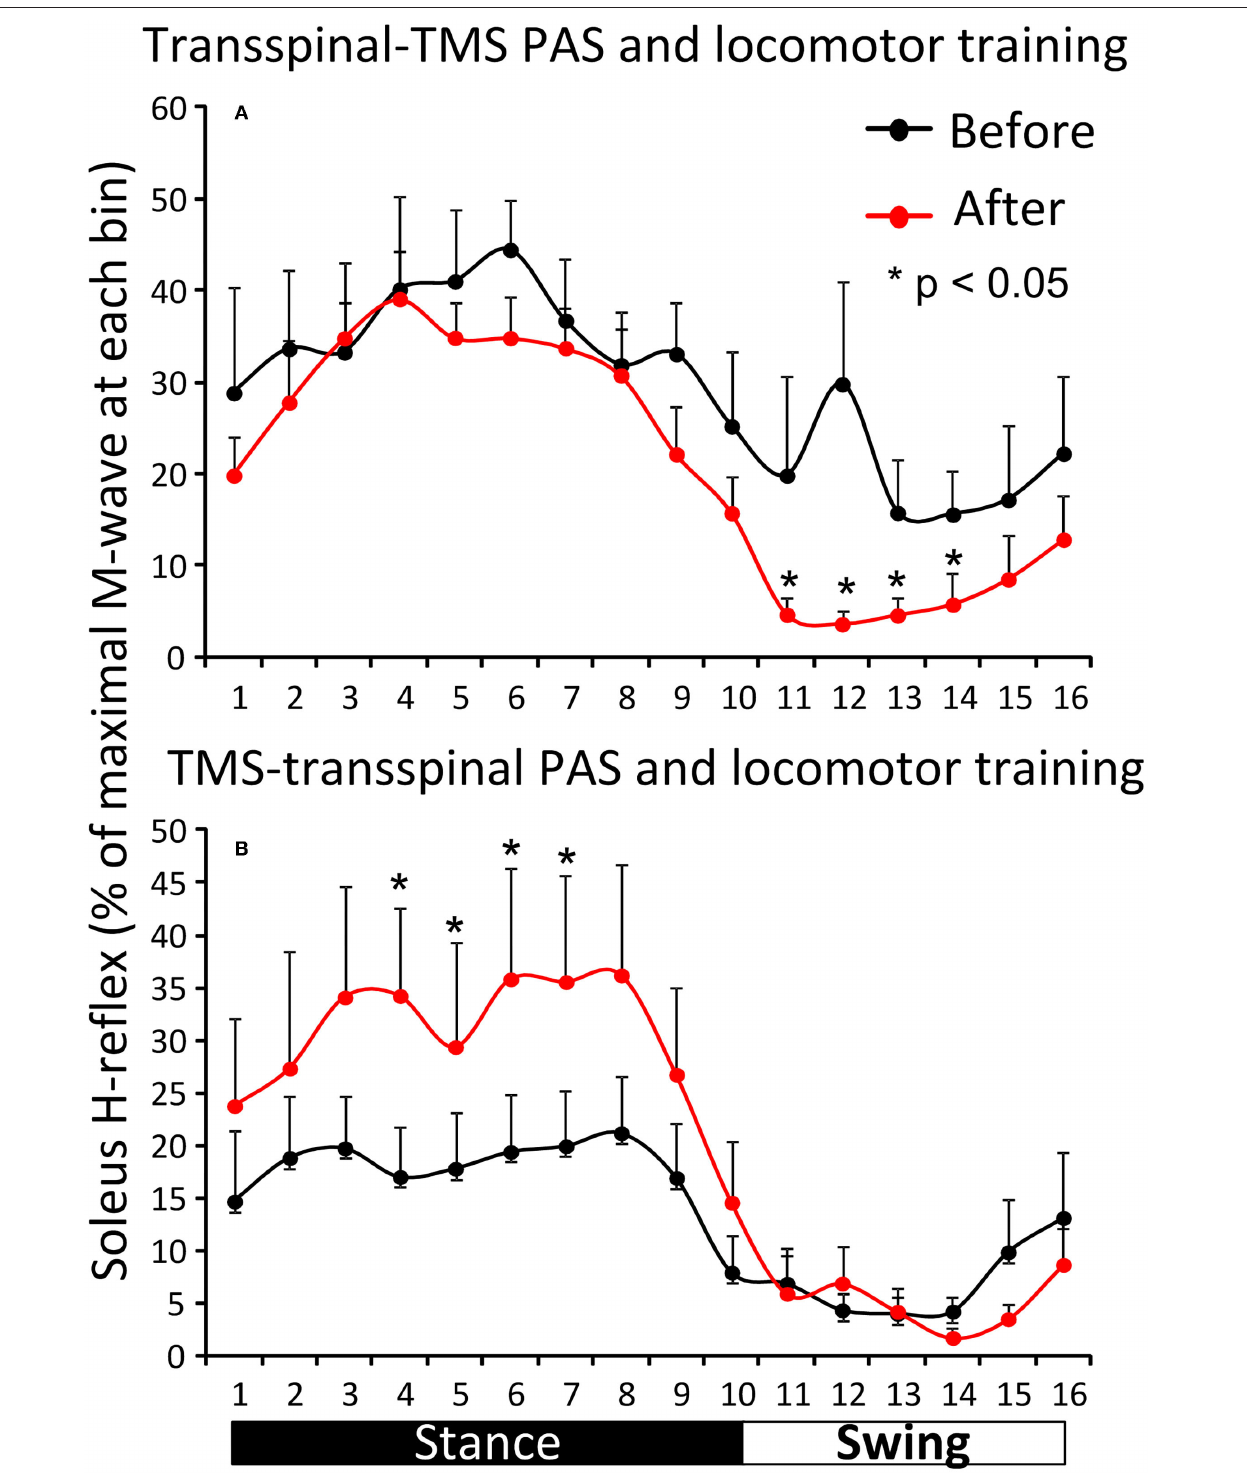
FIGURE 5 | Effects of transspinal and TMS PAS and locomotor training on soleus H-reflex during assisted stepping. Overall amplitude of the soleus H-reflex before and after transspinal-TMS PAS (A) and TMS-transspinal PAS (B) and locomotor training grouped for each protocol based on the targeted less impaired leg by TMS. The step cycle was divided into 16 equal bins. Bin 1 corresponds to heel strike. Bins 8, 9, and 16 correspond approximately to stance-to-swing transition, swing phase initiation, and swing-to-stance transition, respectively. PAS, paired associative stimulation; TMS, transcranial magnetic stimulation. Error bars indicate the SEM. * p <